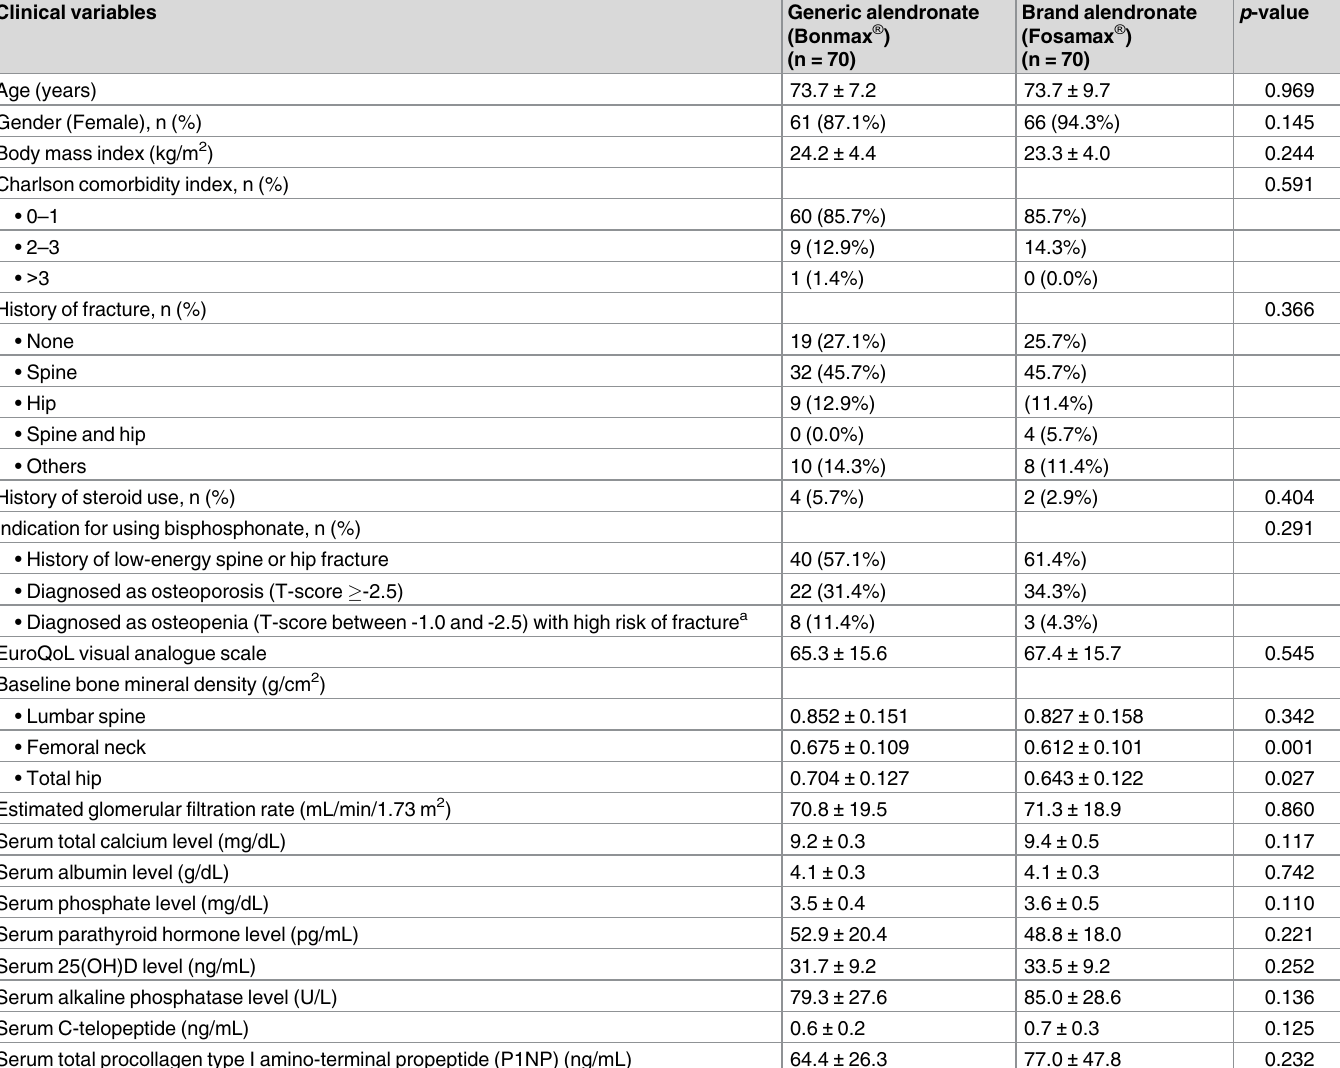
Table 1. Patient demographic and baseline clinical and laboratory